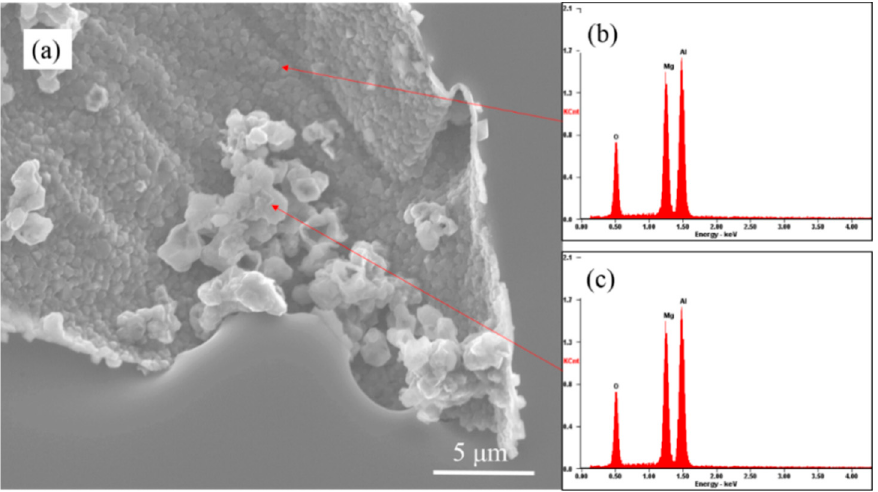
Figure 14. ( a ) The micro-morphology of 5083 alloy scraps after being held in Al-4.5Mg alloy melt for 30 min; ( b ), ( c ) Corresponding EDS results.